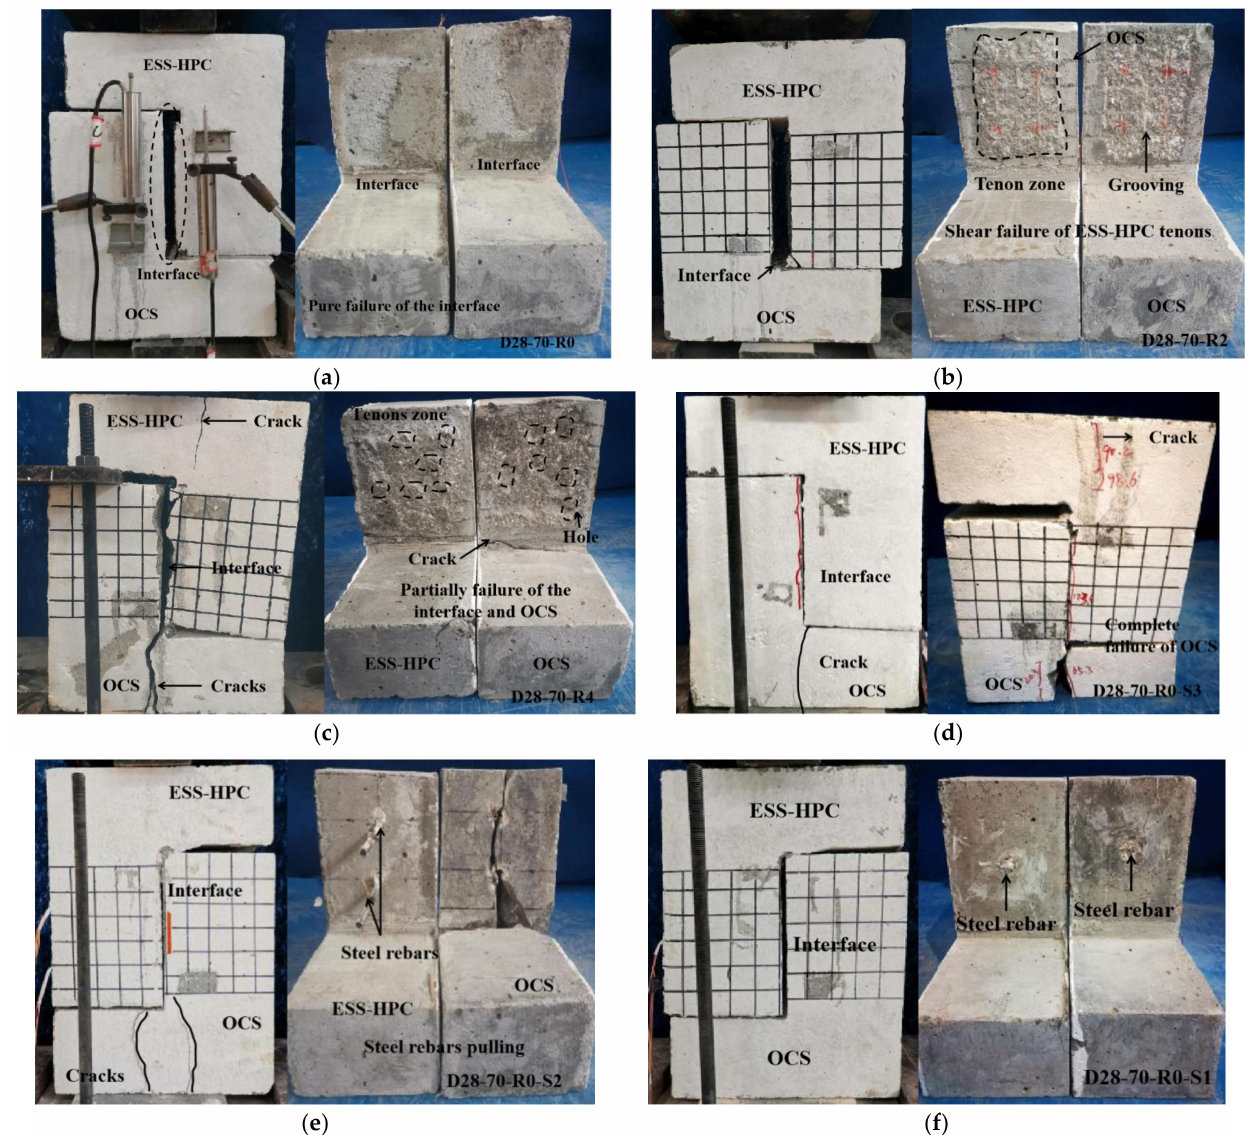
Figure 6. Failure modes of specimen. ( a ) Type A; ( b ) Type A/B; ( c ) Type B; ( d ) Type C; ( e ) Type D; ( f ) Type E.